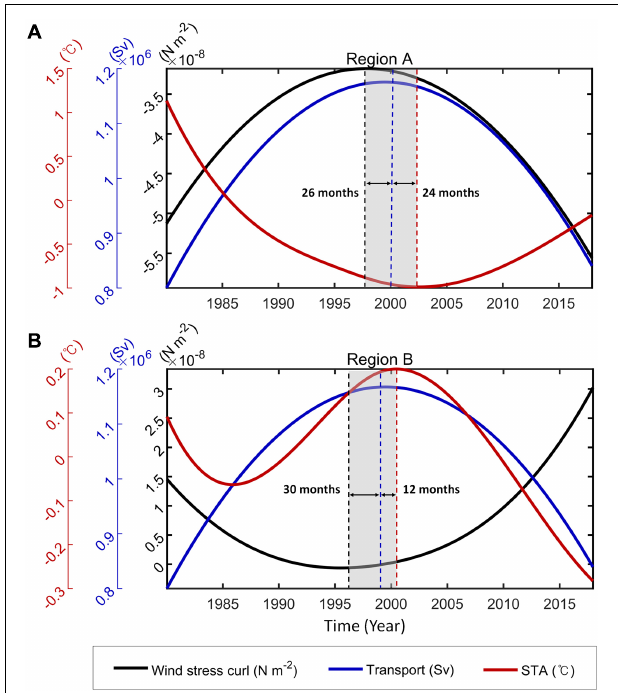
FIGURE 6 | Time series of the decadal IMF of each variable in (A) Region A and (B) Region B. Black, blue, red lines indicate the wind stress curl, volume transport at Mid-ES, and subsurface temperature anomaly (STA), respectively. Each dotted line indicates the conversion point and gray shaded parts imply the time lag ( ∼ 3 years) between